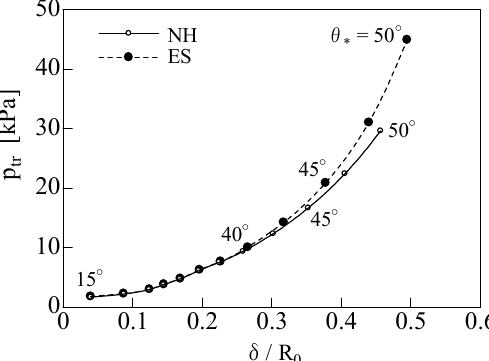
Fig.6 Increase in transmural pressure with increasing non-dimensional displacement In Fig. 8, the distributions of the principal stress resultants contact angles of θ = 40 ° and 50 ° . The points indicated by the black circles are the * boundary points between the contact and no-contact regions. The stress resultant T T for both the NH and ES materials, and both stress resultants for the always larger than s ES material are always larger than those for the NH material because the deformation of